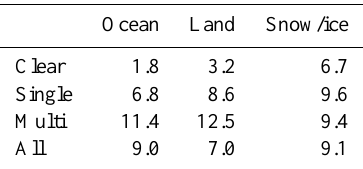
Table 7. TOA instantaneous footprint-level SW flux uncertainties (Wm − 2 ) under clear-sky, single-layer clouds, multi-layer clouds, and all-sky conditions over three surface types based upon MISR flux consistency